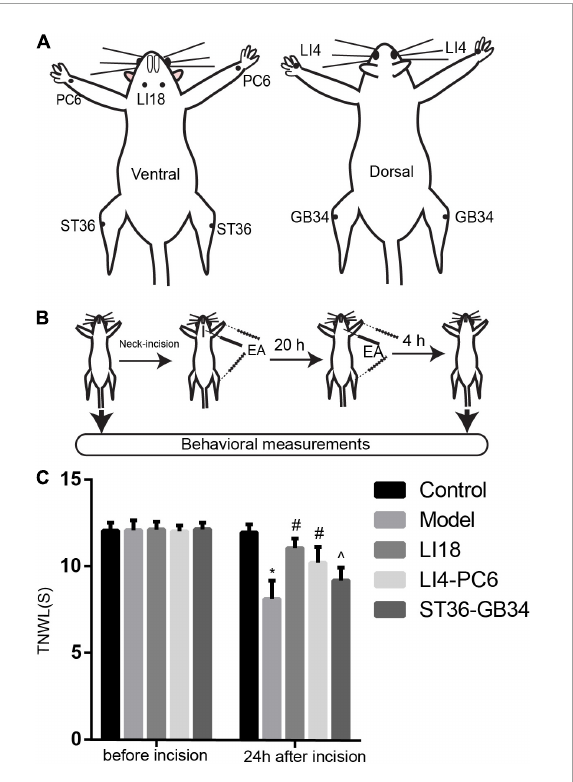
FIGURE1 Electroacupuncture (EA) increases thermal pain threshold (TPT, thermal neck withdrawal latency, TNWL) in rats with incisional neck pain. (A) The location of LI18, LI4, PC6, ST36, and GB34 in rats. (B) Schematic diagram of experimental procedures of EA treatment and behavioral measurements. (C) Effect of EA at Futu (LI18), Hegu (LI14)-Neiguan (PC6), and Zusanli (ST36)–Yanglingquan (GB34) on TPT in rats with incisional neck pain (mean ± SD, n = 13/group). The TPT was significantly increased in both EA LI18 and EA PC6-LI4 groups but not in the EA ST36-GB34 group 24 h after incision. * P < 0.01, vs. the control group; # P < 0.05, vs. the model group; ˆ P < 0.05, vs. the EA LI18